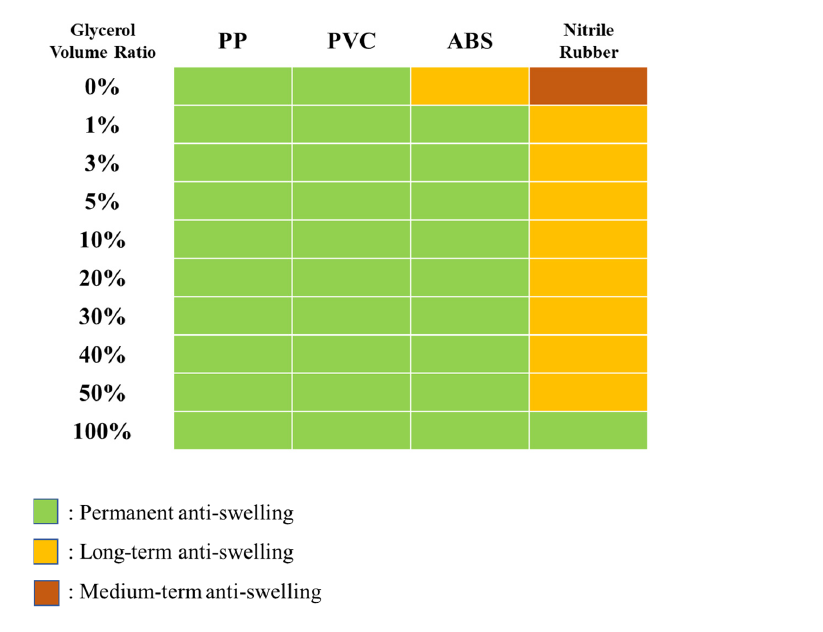
Figure 4. Anti-swelling properties of polymers (PP: polypropylene; PVC: polyvinyl chloride; ABS: acrylonitrile butadiene styrene plastic).